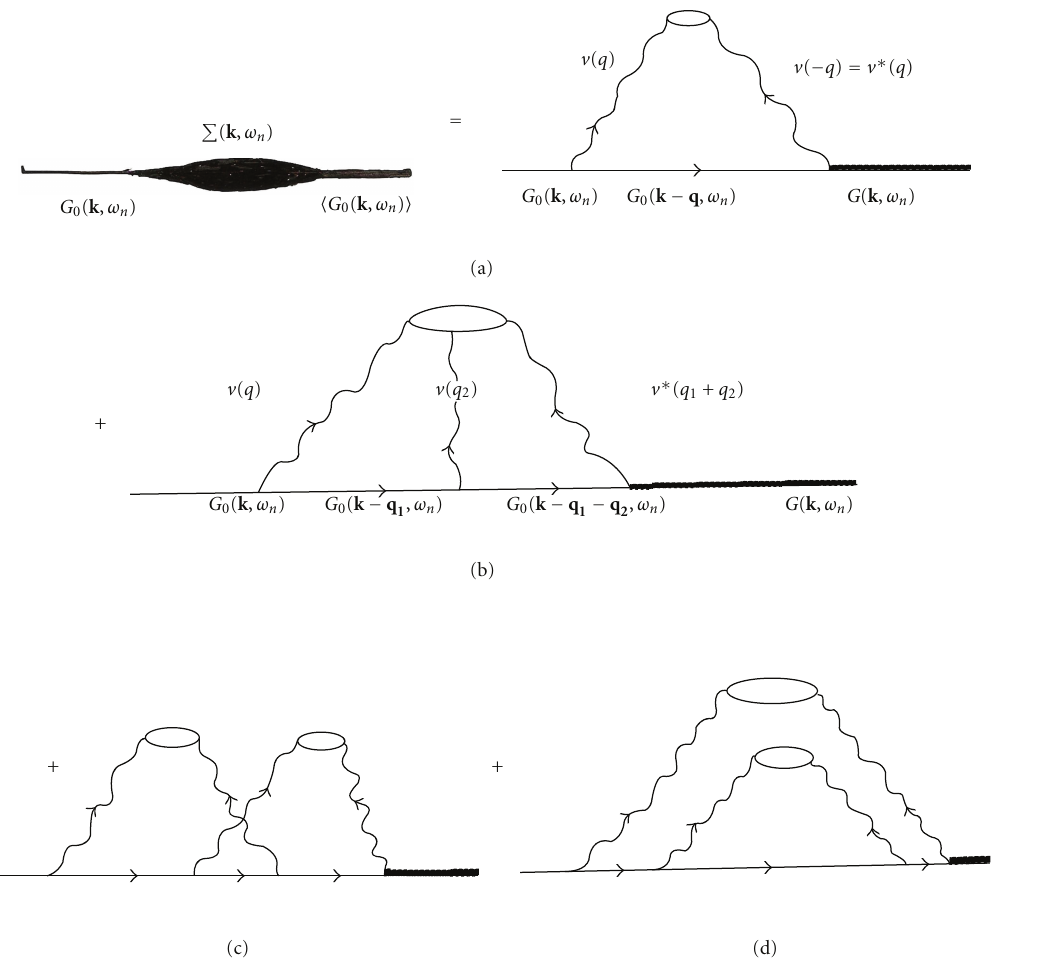
Figure 1: A few diagrams contributing to the self-energy. The wiggly lines carry momentum but no energy. The total momentum entering each impurity vertex, depicted by a slim ellipse, is zero. We have assumed that impurities are alike and distributed randomly. Whereas Figures 1(a) and 1(b) correspond to one impurity vertex, Figures 1(c) and 1(d) correspond to a product of four impurity potentials with nonzero averages. These are the cases where two impurities each gives rise to two potentials. Thus the figures involve the interference of the scattering by more than one impurity. We have assumed low concentration of impurities and therefore these figures yield smaller contributions compared to those corresponding to Figures 1(a), 1(b), and the other diagrams of the same class involving only one impurity